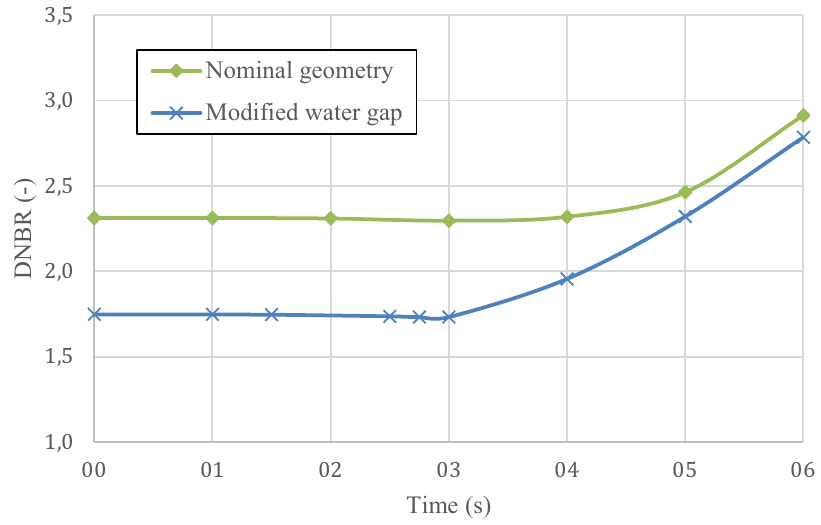
Figure 4. Comparison of the DNB Ratio during a loss of RCP transient for models 1 and